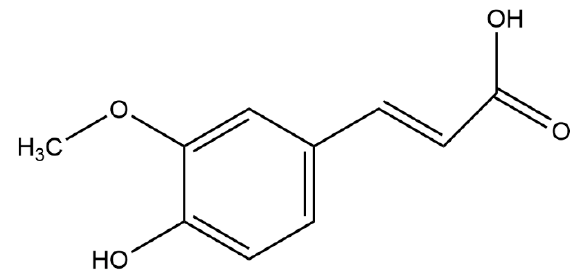
Figure 1. Chemical structure of ferulic acid.